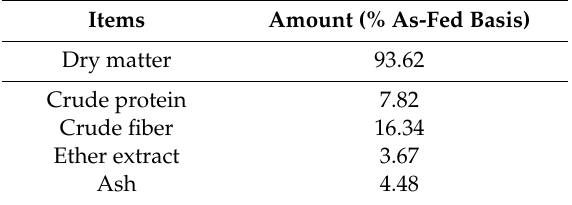
Table 1. Nutrient composition of spent mushroom ( C. militaris ).